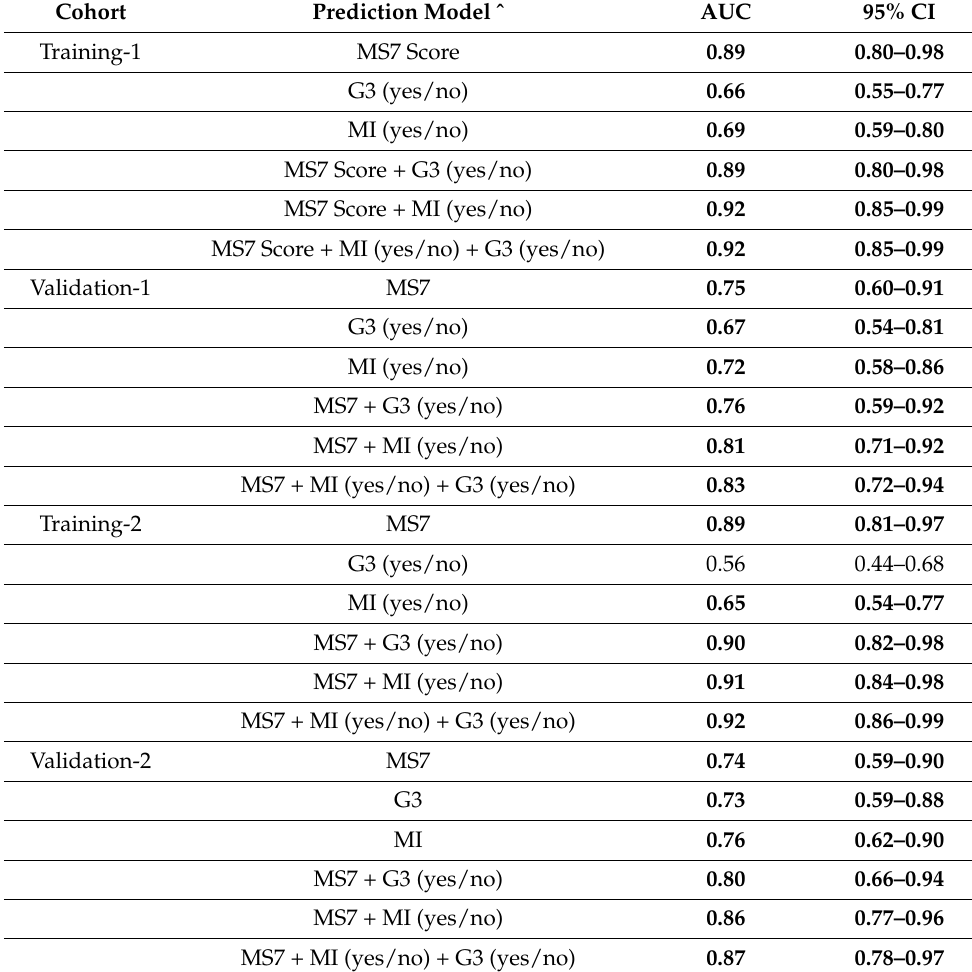
Table 2. Predicting nodal and distant metastasis in endometrioid endometrial cancer cohorts